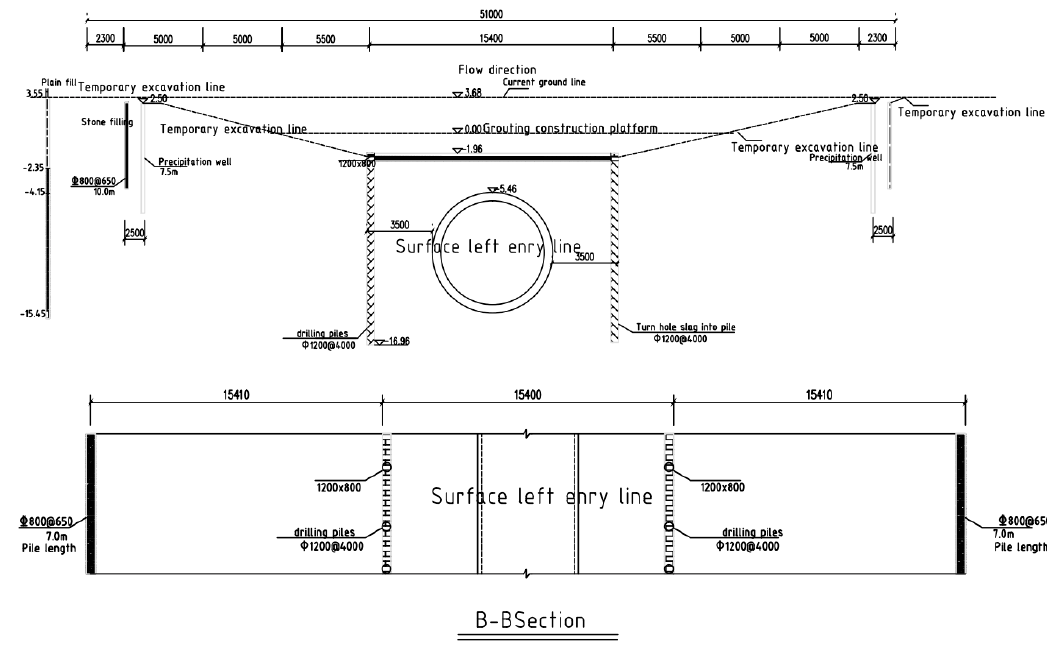
Figure 4. Anti-uplift protection measures for the left tunnel.